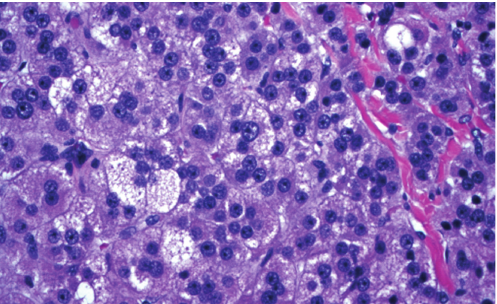
Figure 1: Adrenal cortical adenoma demonstrating focal high grade nuclear atypia.